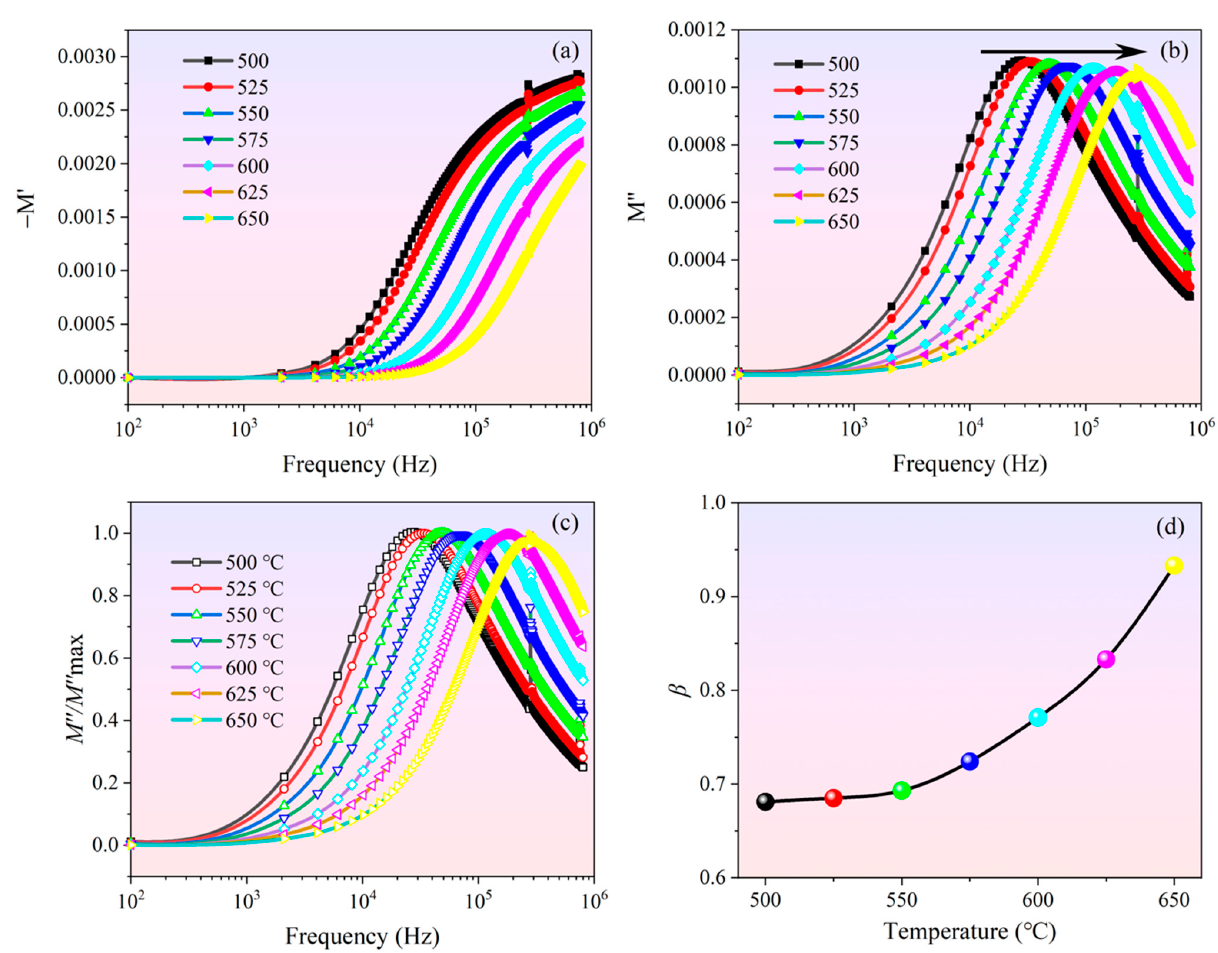
Figure 7. Electrical modulus spectroscopy of the BGTN − 0.2Cr ceramic at high temperature: ( a ) – M ′ ; ( b ) M ″ ; ( c ) M ″ / M ″ max ; ( d ) temperature dependence of β .